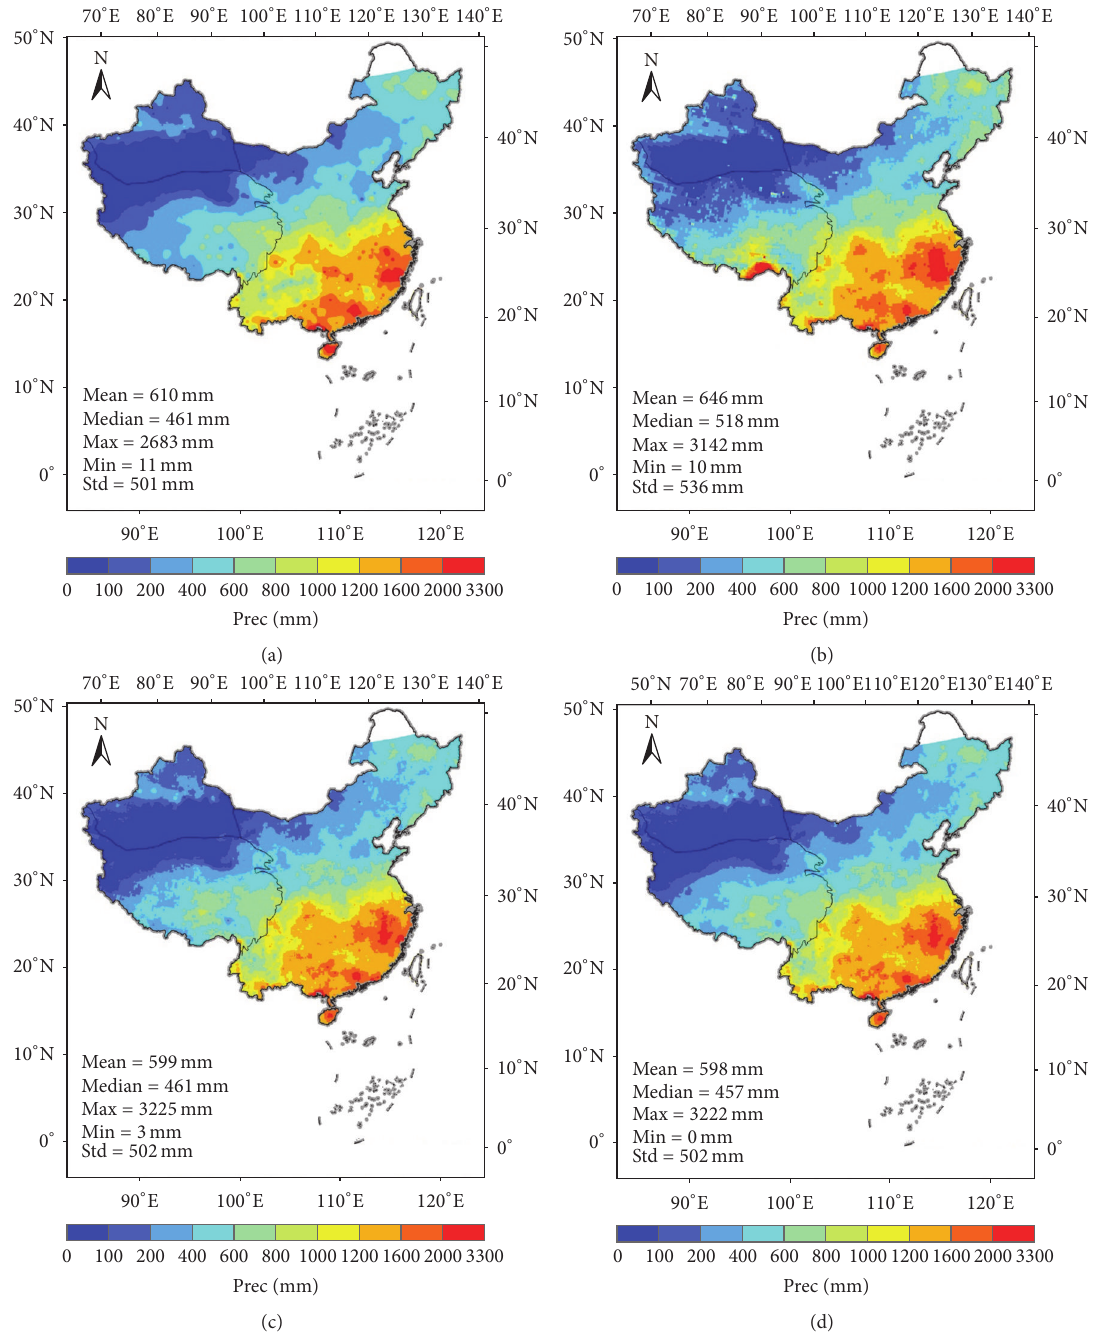
Figure 8: Comparison of spatial distribution of annual gauge precipitation (a), original TRMM precipitation (b), and corrected TRMM precipitation obtained from monthly (c) and annual (d) LRMs in 2014 over China